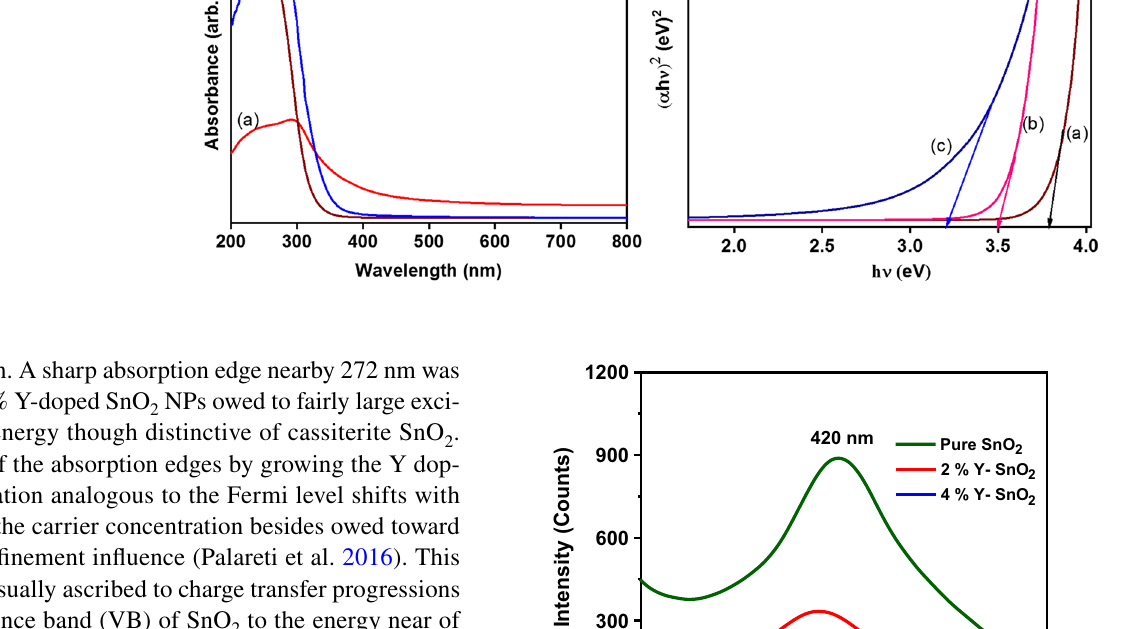
Fig. 5 A UV spectra and B Bandgap energy of (a) SnO 2 , (b) 2% Y-doped SnO 2 NPs and (c)